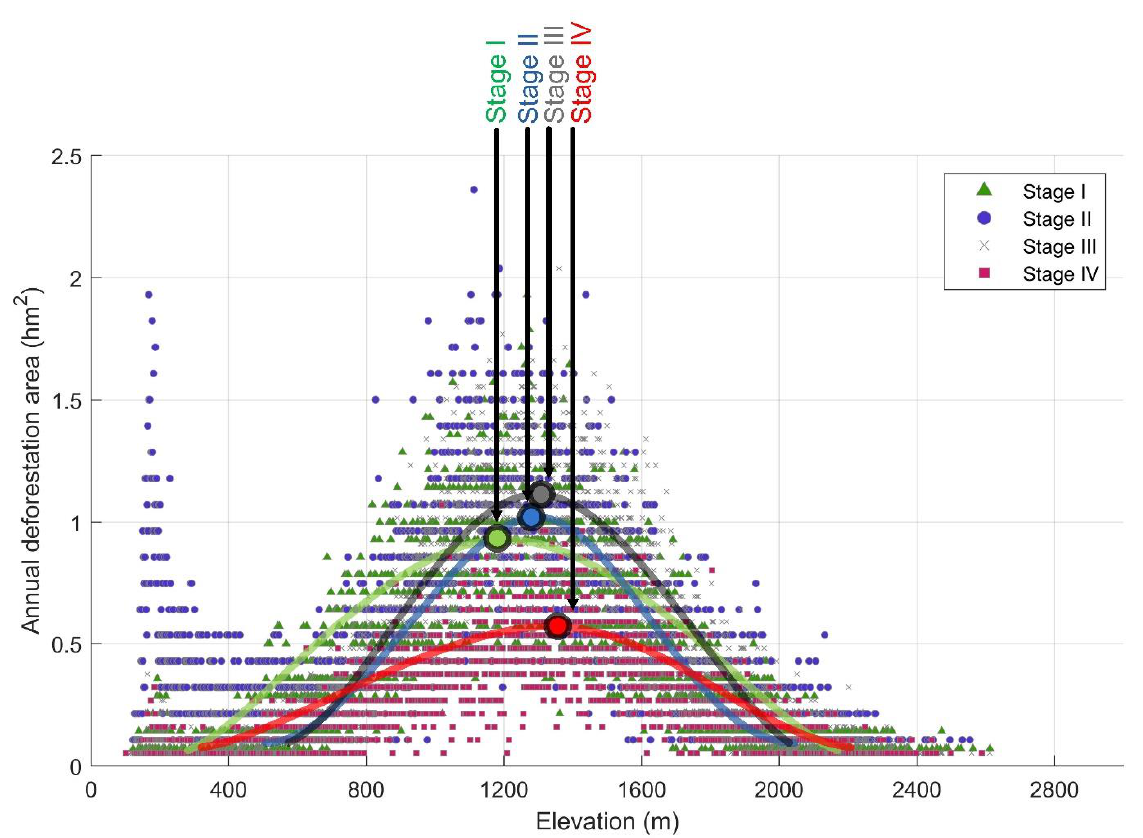
Figure 7. Comparison of variations in annual deforestation area with elevation for Stages I–IV from 2003 to 2015 in upland Myanmar.